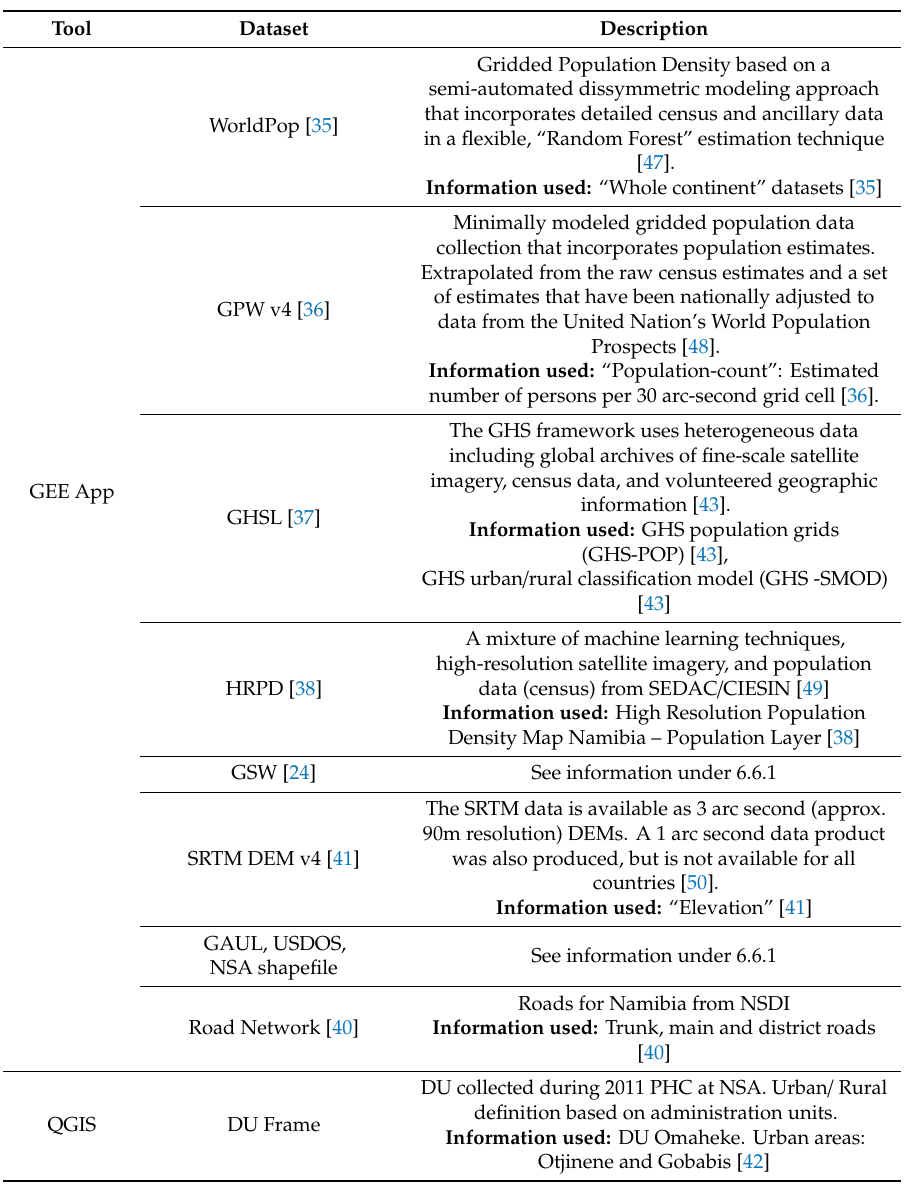
Table 2. Tools and EO data sources for the evaluation of SDG Indicator 9.9.1 (Road